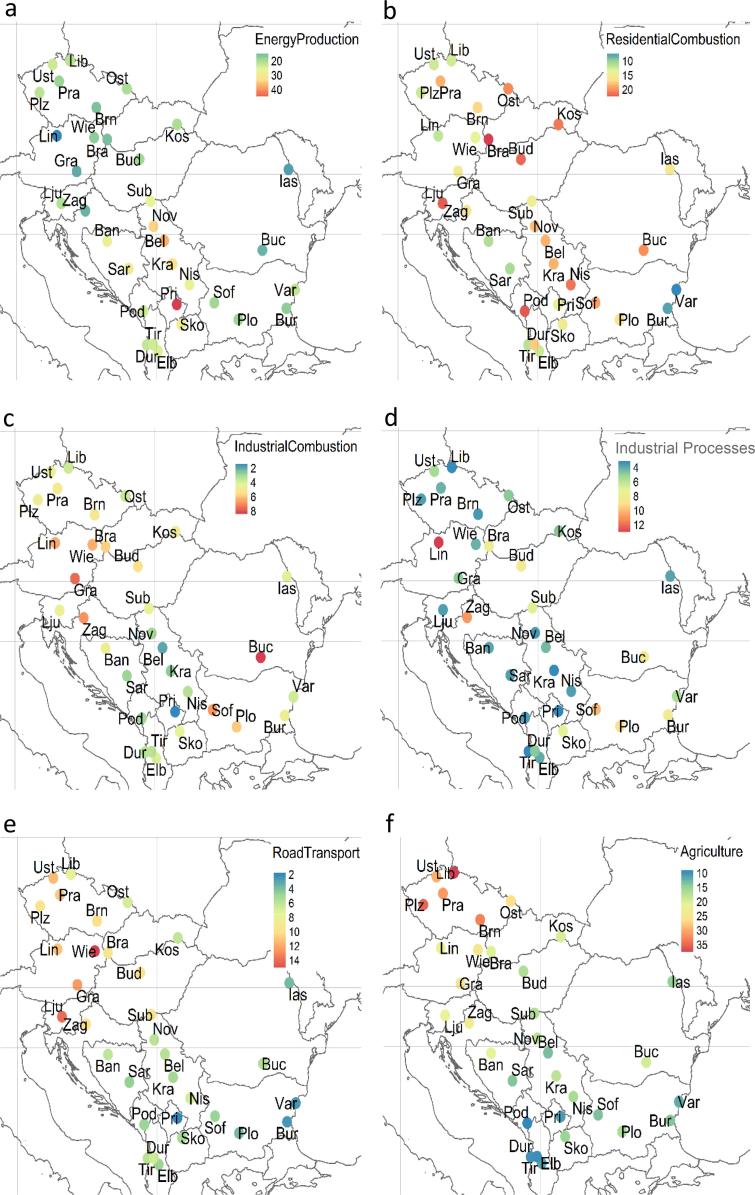
Percentage impact of selected activity sources to the 33 studied cities estimated with SHERPA. Energy production, Residential and commercial combustion, Combustion in Industry, Industrial (production) processes, Road transport and Agriculture. The values are provided in numeric format in Tables S2 and S3.